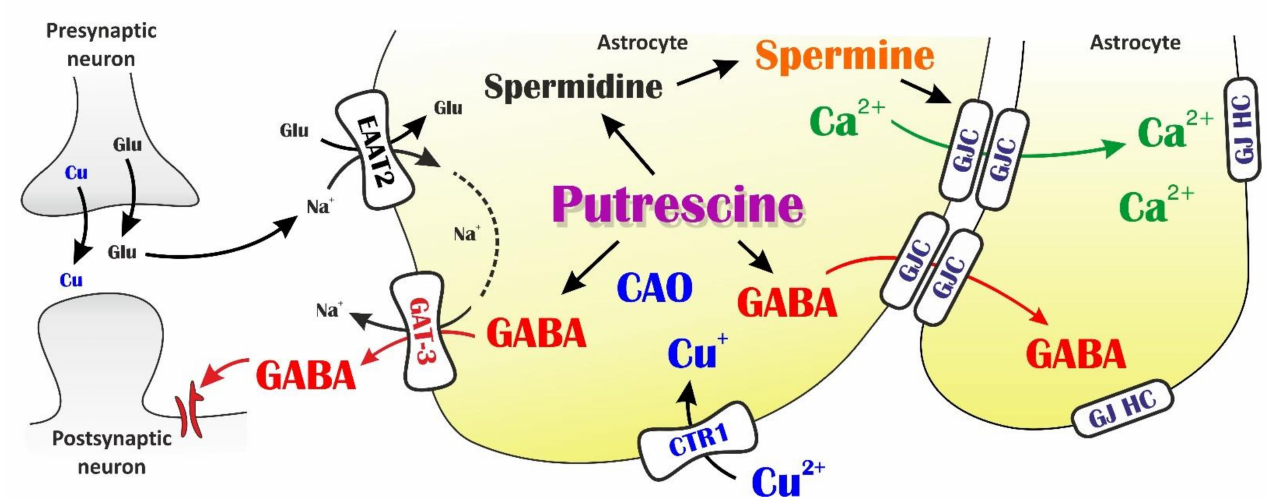
Figure 4. Schematic representation of dual role for astroglial copper-assisted polyamine metabolism in controlling neuronal excitability. Astrocytic putrescine can be catabolised to GABA and this GABA can release to the extrasynaptic space in response to Glu transporter (EAAT)-mediated Na + influx. The released GABA generate tonic current on extrasynaptic GABAa receptors. Since the putrescine-GABA conversion is catalyzed by copper containing amine oxidases (CAOs), intracellular copper level can influence the amount of GABA accumulated in astrocytes. By inhibiting or stimulating the astrocytic copper transporter CTR1, the releasable GABA pool can be controlled. On the other hand, putrescine is also metabolized to spermine which contributes to opening of gap junction channels (GJCs), through which Ca 2+ and other substances can be redistributed through the astrocytic syncytium and consequently neuronal activity is spread over a large